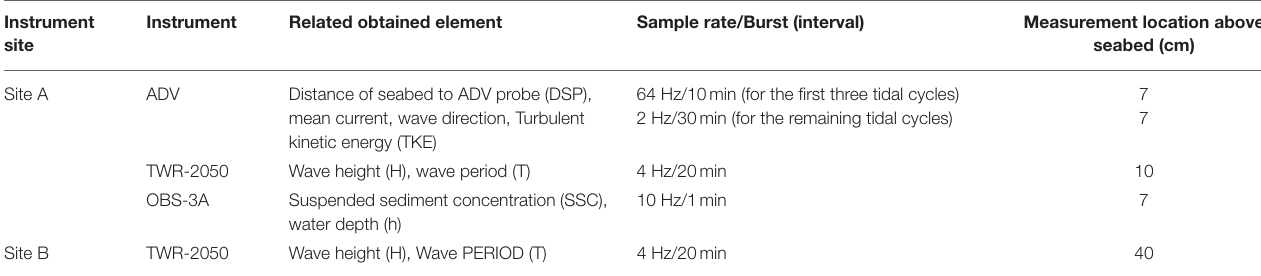
TABLE 1 | Overview of instrument setup and related obtained elements during the